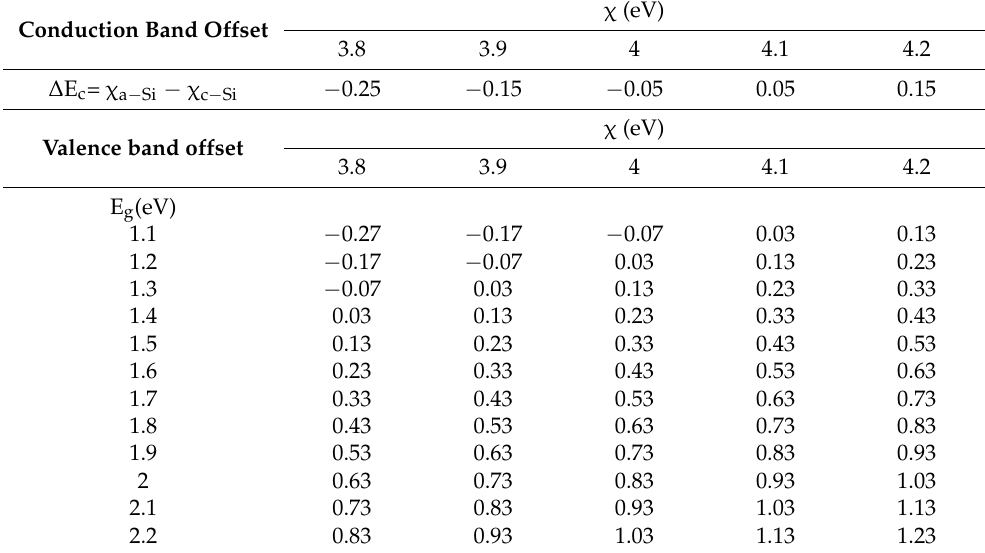
Table 2. Band diagram offset between